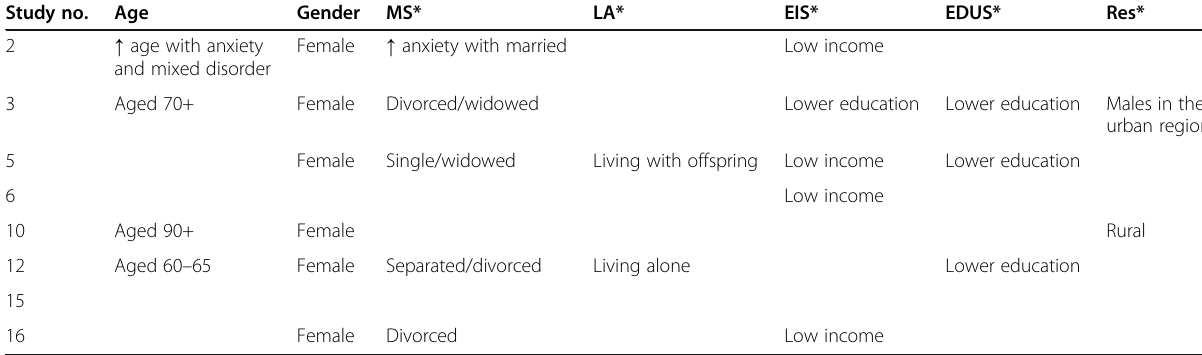
Table 4 Reported significant positive correlation of depression and anxiety with sociodemographic status Study no.